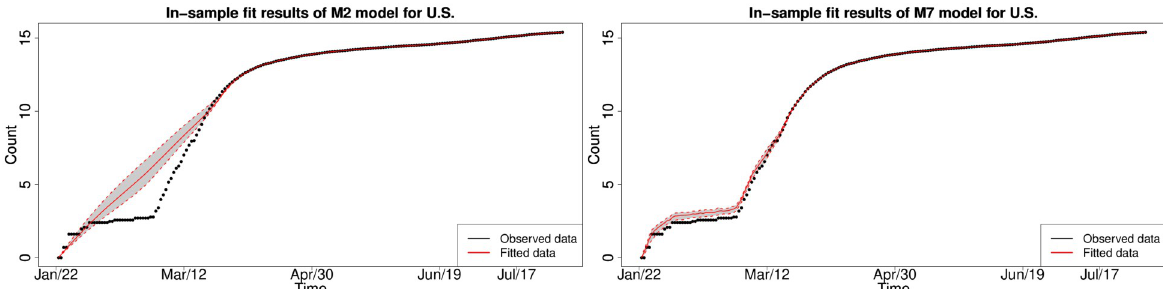
Fig 8. In-sample fit results for the US for the period January 2020—August 2020. In-sample fitted plot (y-axis in log scale) for the US by Model 2 (baseline, left) and Model 7 (best, right) (January 2020—August 2020).